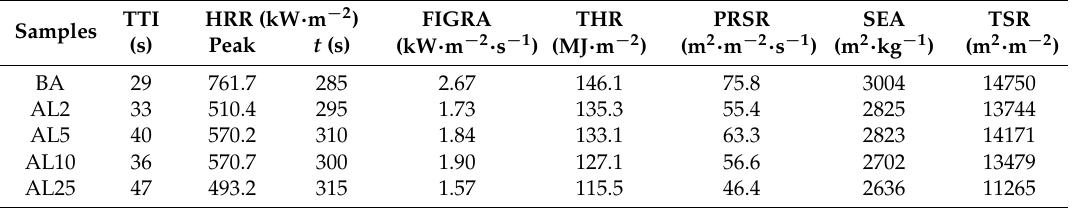
Table 2. Flammability characteristics obtained from cone calorimeter tests.